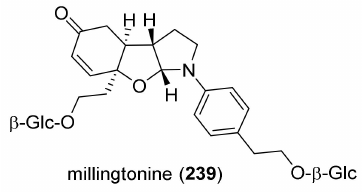
Figure 3. Millingtonine